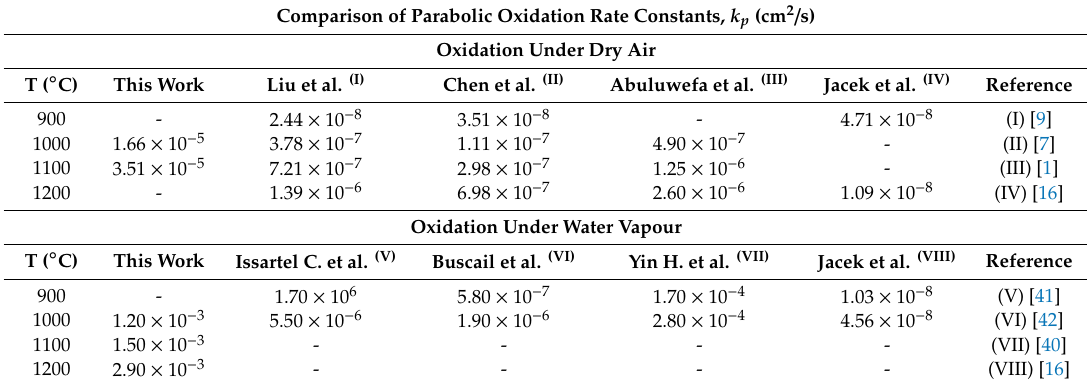
Table 5. Comparison of parabolic oxidation rate ( k p ) under dry air and water vapour